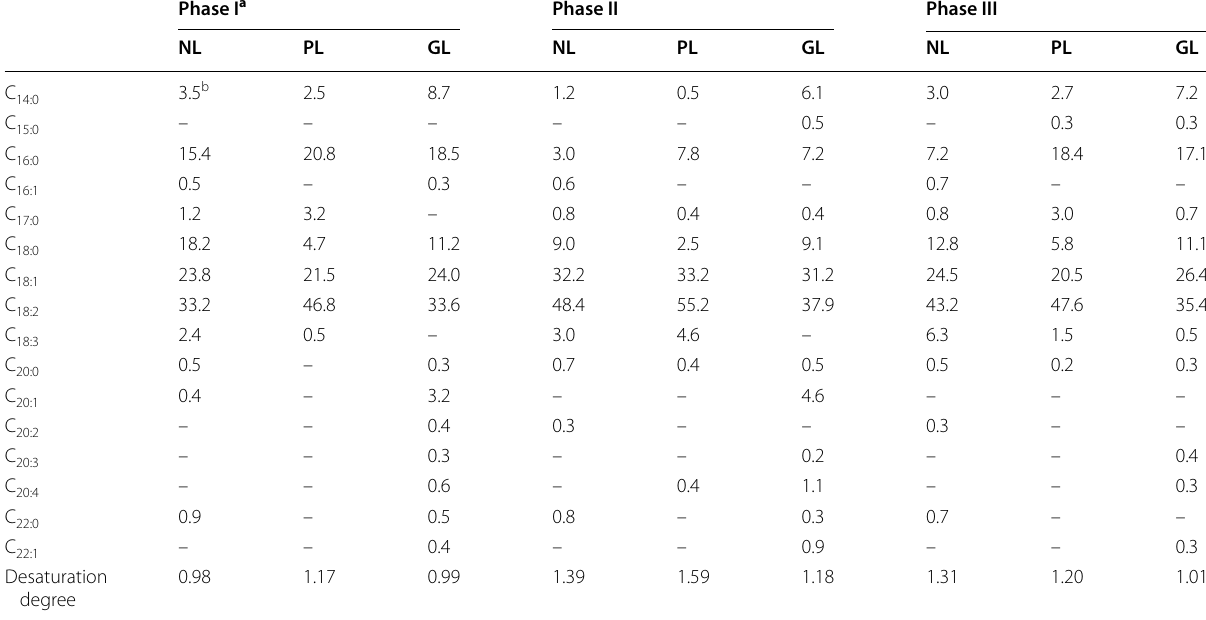
a Sampling time of Phase I, Phase II and Phase III were 72, 96, and 120 h, respectively b All value mean the relative content of fatty acids, % of lipid fraction